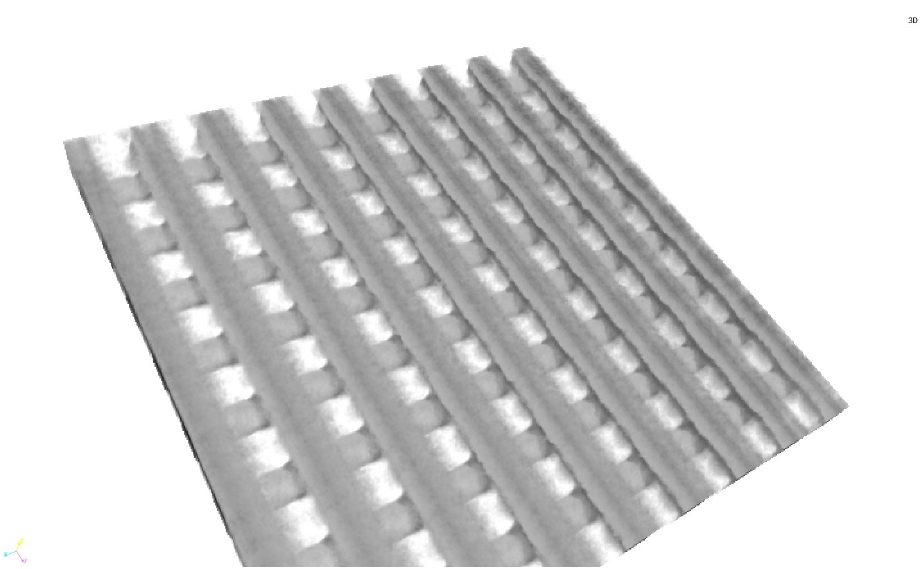
Figure 25: X-ray based three-dimensional (3D) optical inspection of